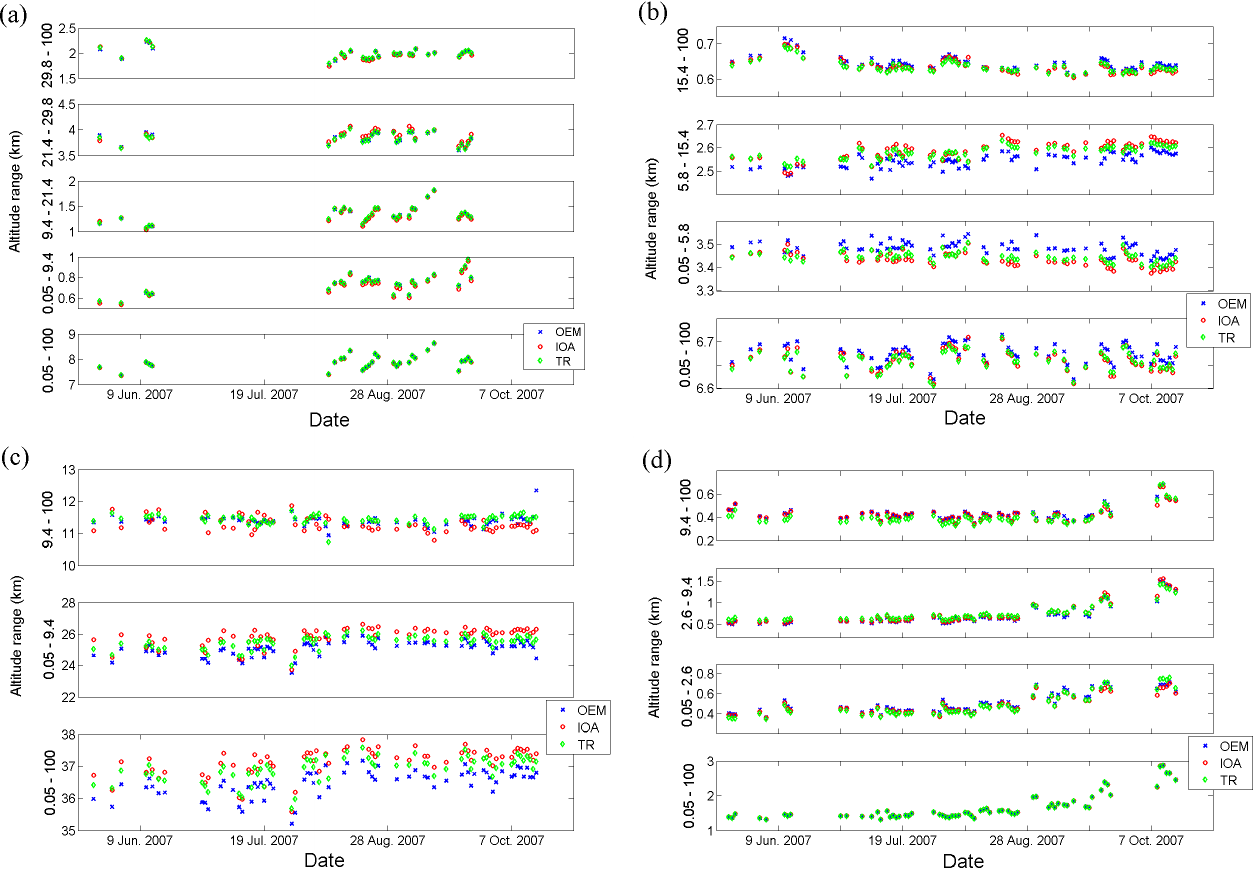
Figure 12. Time series of the total and partial column amounts (in 10 18 molec/cm 2 ) of (a) O 3 , (b) N 2 O, (c) CH 4 and (d) CO during the FTIR campaign at St.-Denis in 2007, retrieved with the OEM (blue crosses), IOA (red circles) and TR (green diamonds), respectively.